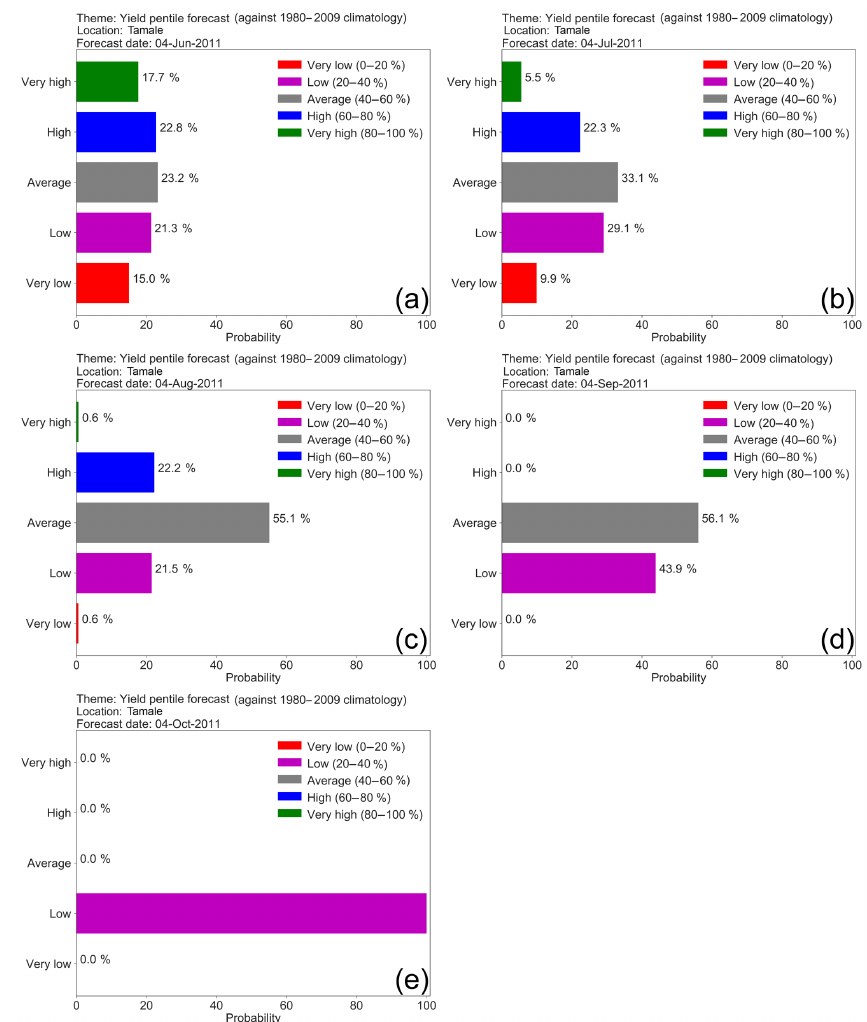
Figure 14. Yield probability forecast for the year 2011 for five forecast dates, (a) 4 June, (b) 4 July, (c) 4 August, (d) 4 September and (e) 4 October, when ensembles are weighted by IRI seasonal rainfall